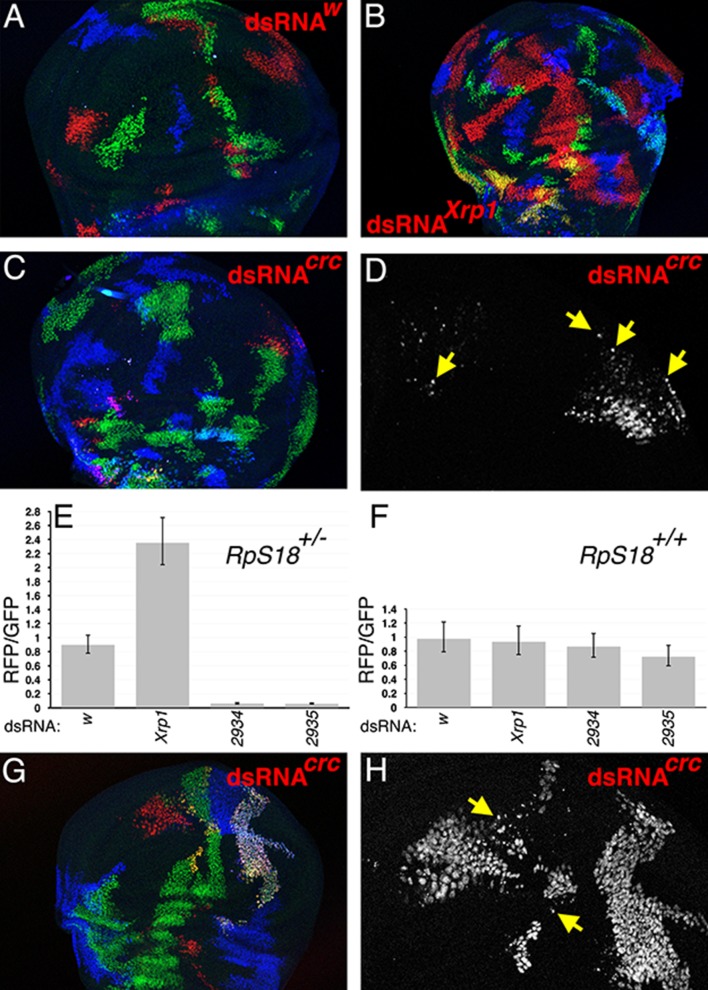
dATF4/crc requirement in wild type and Rp+/- wing discs.(A) In the TIE-DYE method, independent recombination events generate parallel clones expressing GFP (green), Gal4 (detected through UAS-RFP expression in red), and b-Gal (blue). These parallel clones grow equivalently in RpS18+/- wing discs. In this control, dsRNA targeting transcripts from the white gene was co-expressed with RFP under Gal4 control. (B) Co-expression of dsRNA targeting Xrp1 increased the contribution of RFP-positive clones in RpS18+/- wing discs. (C) Co-expression of dsRNA targeting dATF4/crc decreased the contribution of RFP-positive clones in RpS18+/- wing discs. (D) Enlarged portion of the wing disc from panel C to show the fragmentation of RFP-positive, dATF4/crc knock-down RpS18+/- cells (eg arrows). (E) Quantification of growth for various dsRNA-expressing RFP-positive clones in RpS18+/- wing discs. Shown is the mean ratio of RFP-positive to GFP-positive areas for each wing disc. Error bars represent ± 1 SEM. Probabilities that clone sizes are the same as for the w control (2-tailed t-tests): Xrp1 - 3.4 × 10−5; 2934–3.1 × 10−12; 2935–2.2 × 10−11. VDRC2934 and VDRC2935 encode independent, previously-validated dsRNAs targeting dATF4/Crc (Kang et al., 2017). Number of wing discs analyzed = 25 (w), 23 (Xrp1), 17 (2934), 26 (2935). (F) Quantification of growth for various dsRNA-expressing RFP-positive clones in RpS18+/+ wing discs. Probabilities that clone sizes are the same as for the w control (2-tailed t-tests): Xrp1 – 0.88; 2934–1.0; 2935–0.68. Number of wing discs analyzed = 17 (w), 26 (Xrp1), 16 (2934), 19 (2935). (G) An example of dATF4/Crc knock-down in RFP-positive clones in a RpS18+/+ wing disc. (H) Enlarged portion of the wing disc shown in G illustrating that, although substantial RFP-positive territories are present, some of these cells are fragmented (eg arrows). Genotypes A) y w hs-FLP; Act < stop < lacZ-NLS Ubi < stop <  eGFP-NLS M(2)56 F/ +; Act < stop < GAL4 UAS-His2A::mRFP/P{TRiP.HMS00017}attP2. B) y w hs-FLP; Act < stop < lacZ-NLS Ubi < stop <  eGFP-NLS M(2)56 F/ +; Act < stop < GAL4 UAS-His2A::mRFP/P{TRiP.HMS00053}attP2. C,D) y w hs-FLP; Act < stop < lacZ-NLS Ubi < stop <  eGFP-NLS M(2)56 F/ +; Act < stop < GAL4 UAS-His2A::mRFP/UAS-dsRNA(Crc)VDRC2935. G,H) y w hs-FLP; Act < stop < lacZ-NLS Ubi < stop <  eGFP-NLS / +; Act < stop < GAL4 UAS-His2A::mRFP/UAS-dsRNA(Crc)VDRC2935.Figure 2—source data 1.Source data for the graph shown in Figure 2E.Figure 2—source data 2.Source data for the graph shown in Figure 2F.